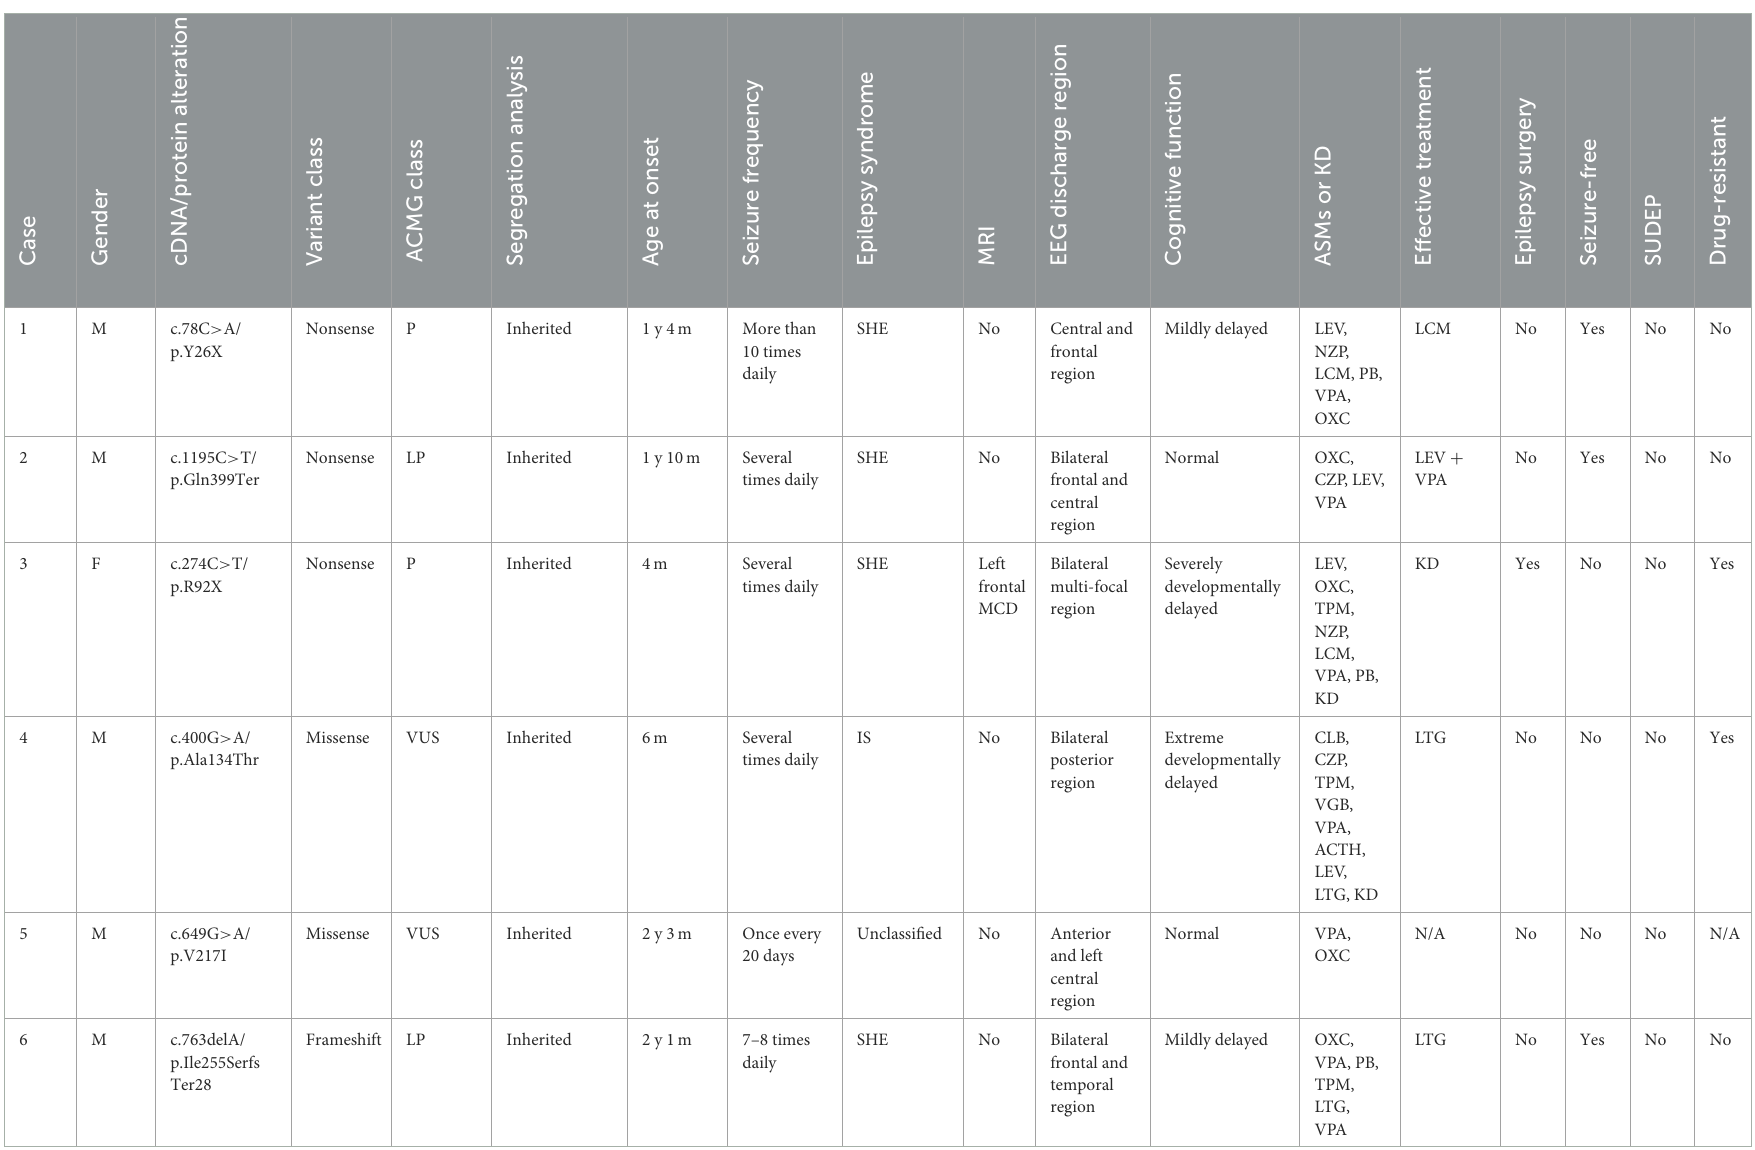
TABLE 2 The genotypes and clinical phenotypes of 11 children with NPRL3 -related